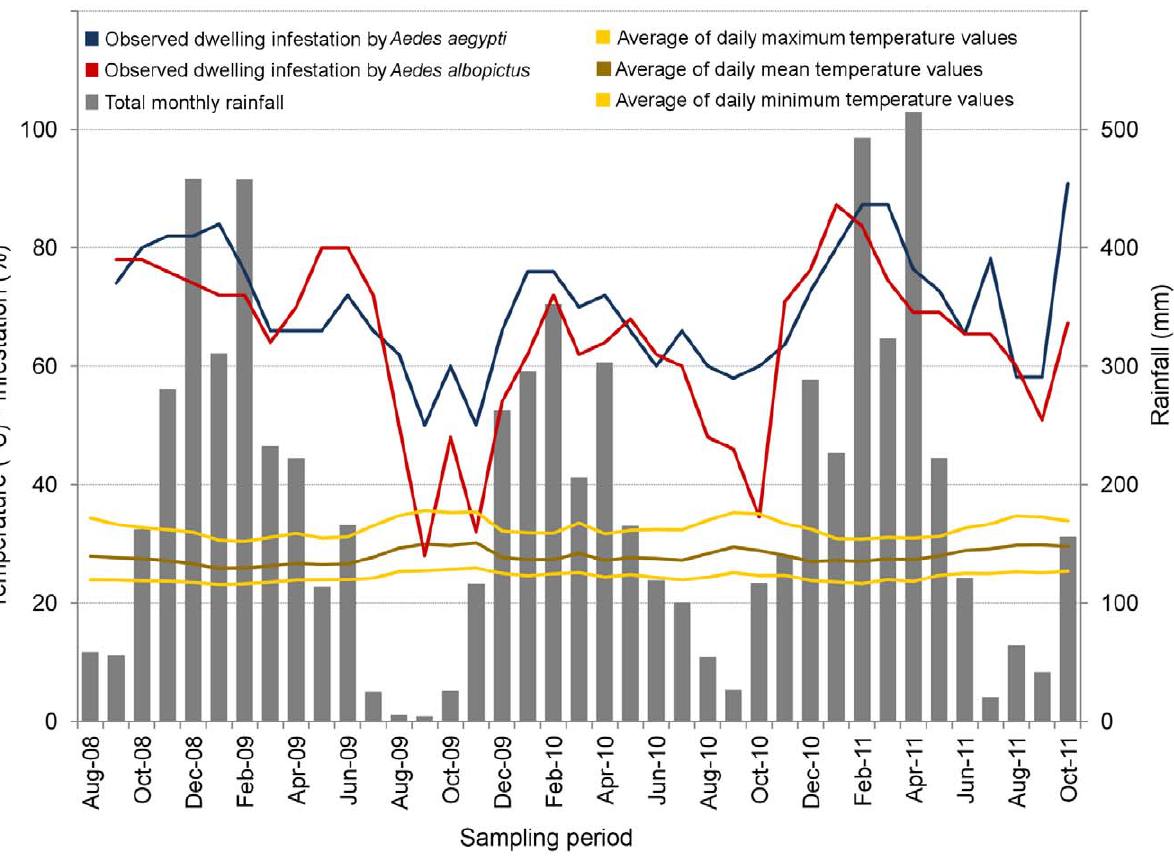
Figure 2. Observed dwelling infestation and meteorological variables during the study period. Dwelling infestation (%; left y axis) by Aedes aegypti and Ae. albopictus ; total monthly rainfall (mm; right y axis); and monthly averages of daily mean, minimum, and maximum temperatures ( u C; left y axis).